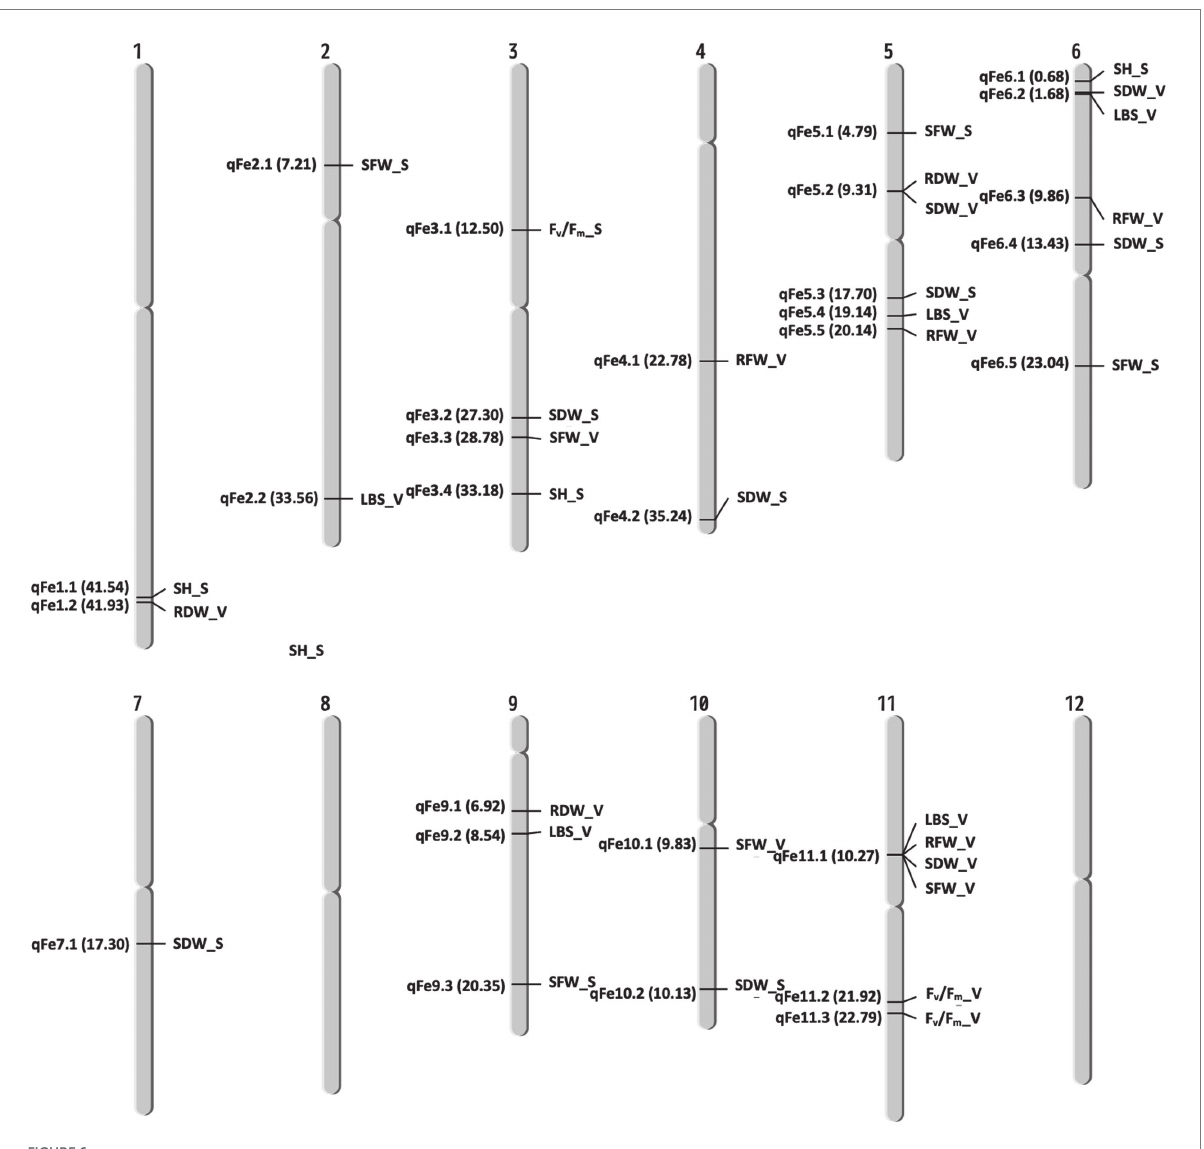
FIGURE 6 Chromosomal location of QTLs associated with different traits at seedling and vegetative stages. S, seedling stage; V, vegetative